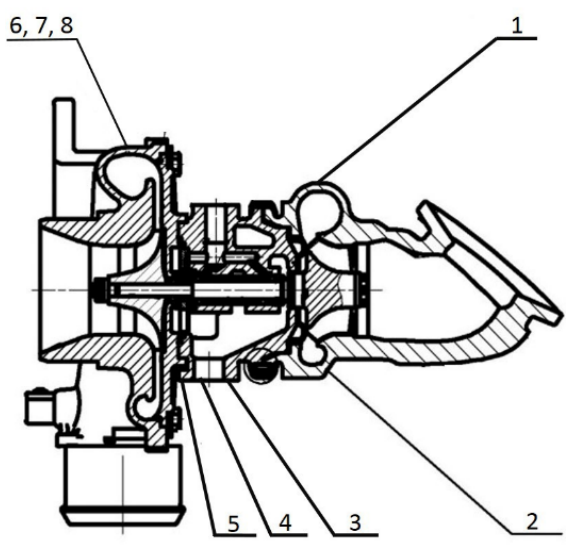
Figure 6. Schematic of installed thermocouples on the turbine housing. The K-type thermocouple was used in this test. It has an operating range of − 200 ◦ C to +1200 ◦ C and accuracy of ± 2 ◦ C. The experimental tests were performed in an engine test cell with a 1.7 L turbocharged engine. The specification of the engine and the turbocharger are provided in Table 3. Table 3. Specifications of engine and turbocharger.